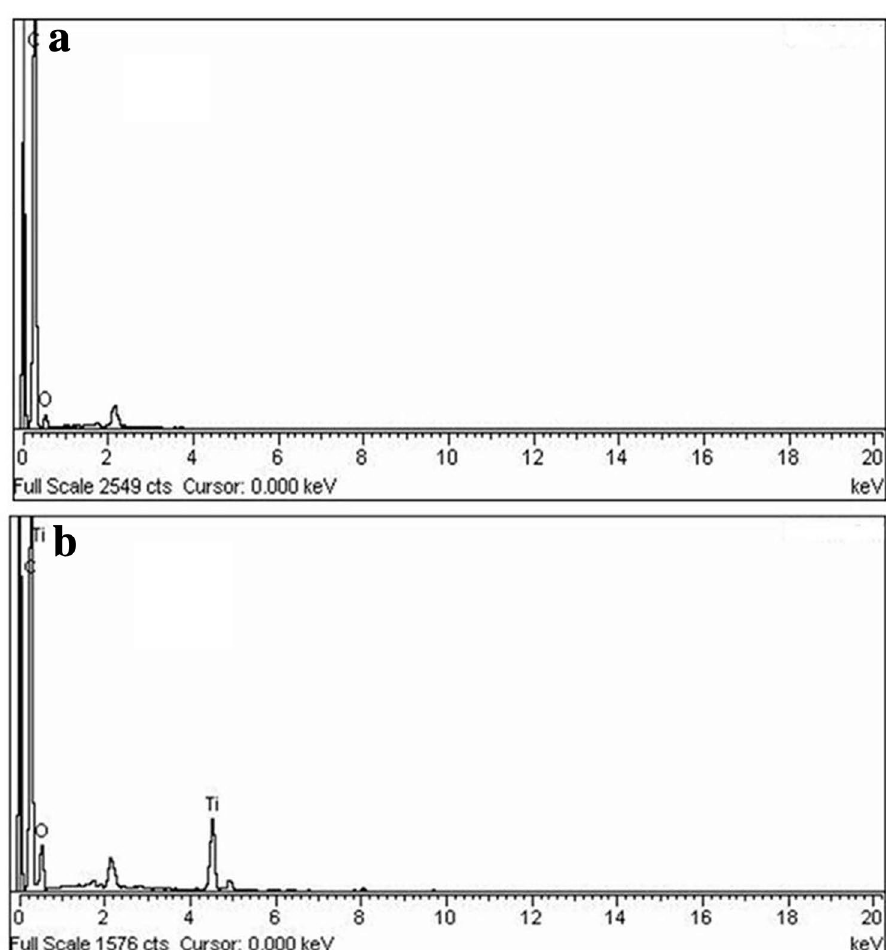
Fig. 2 EDX study of a GNP and